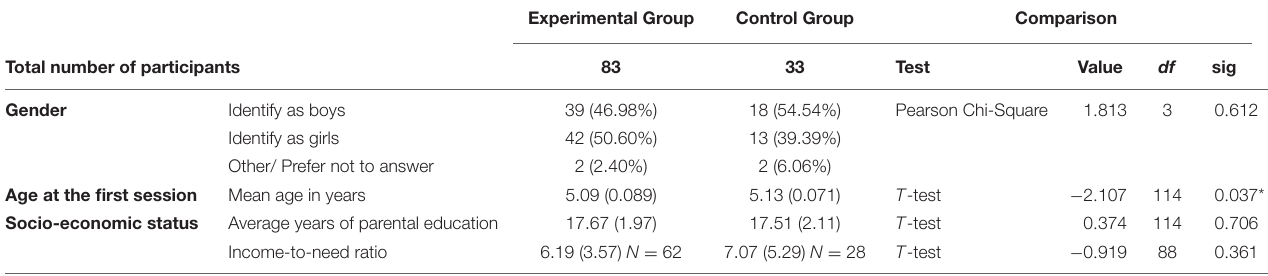
TABLE 1 | Basic demographic information of the experimental and control